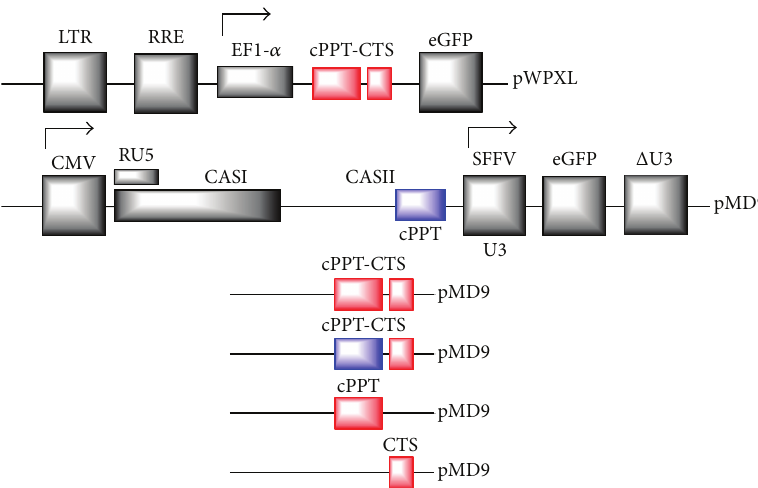
Figure 2: The structural elements of pWPXL and pMD9 parental plasmid backbones are shown: long terminal repeat (LTR) with U3, R, and U5 regions, ref-responsive element (RRE), human elongation factor alpha promoter (EF1- 𝛼 ), gene encoding enhanced green fluorescent protein (eGFP), enhancer/promoter of the human cytomegalovirus immediate early gene (CMV), cis -acting sequences (CASI and CASII), constitutively active spleen focus forming virus U3 promoter (SFFV U3), and internally deleted U3 region of the 3 󸀠 LTR ( Δ U3). Foamy viral cPPT was replaced with cPPT (HIV) in different variations. CTS was deleted or inserted in accordance with the scheme shown above.